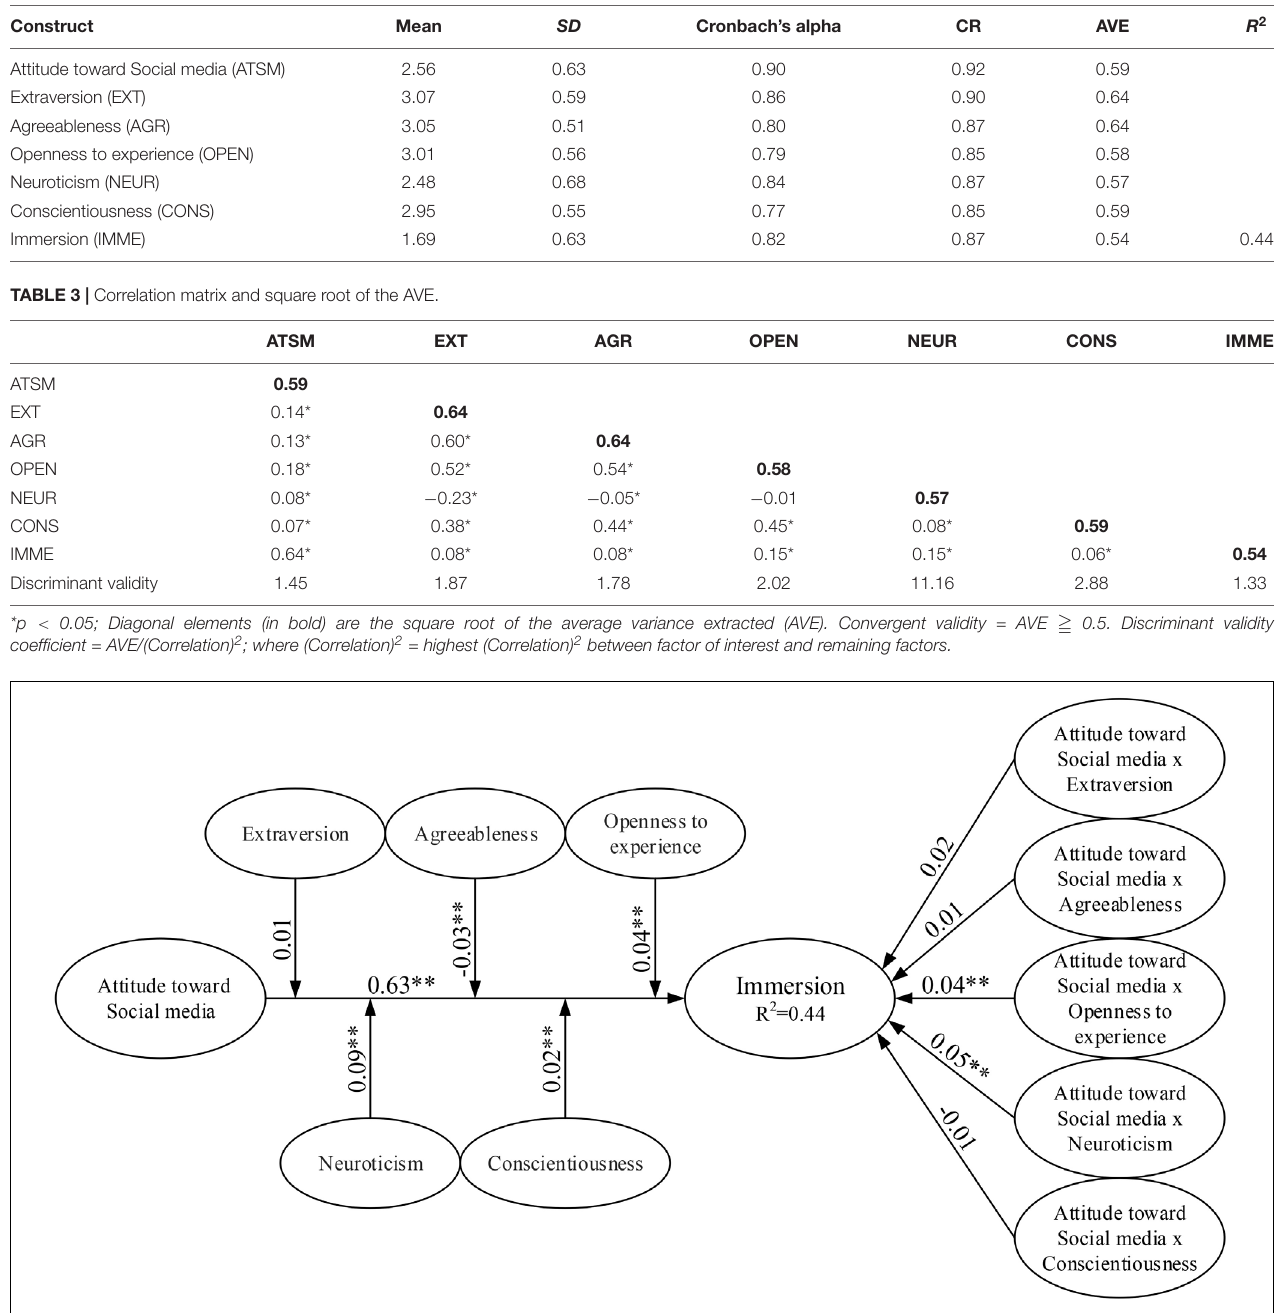
TABLE 2 | Validity and reliability.